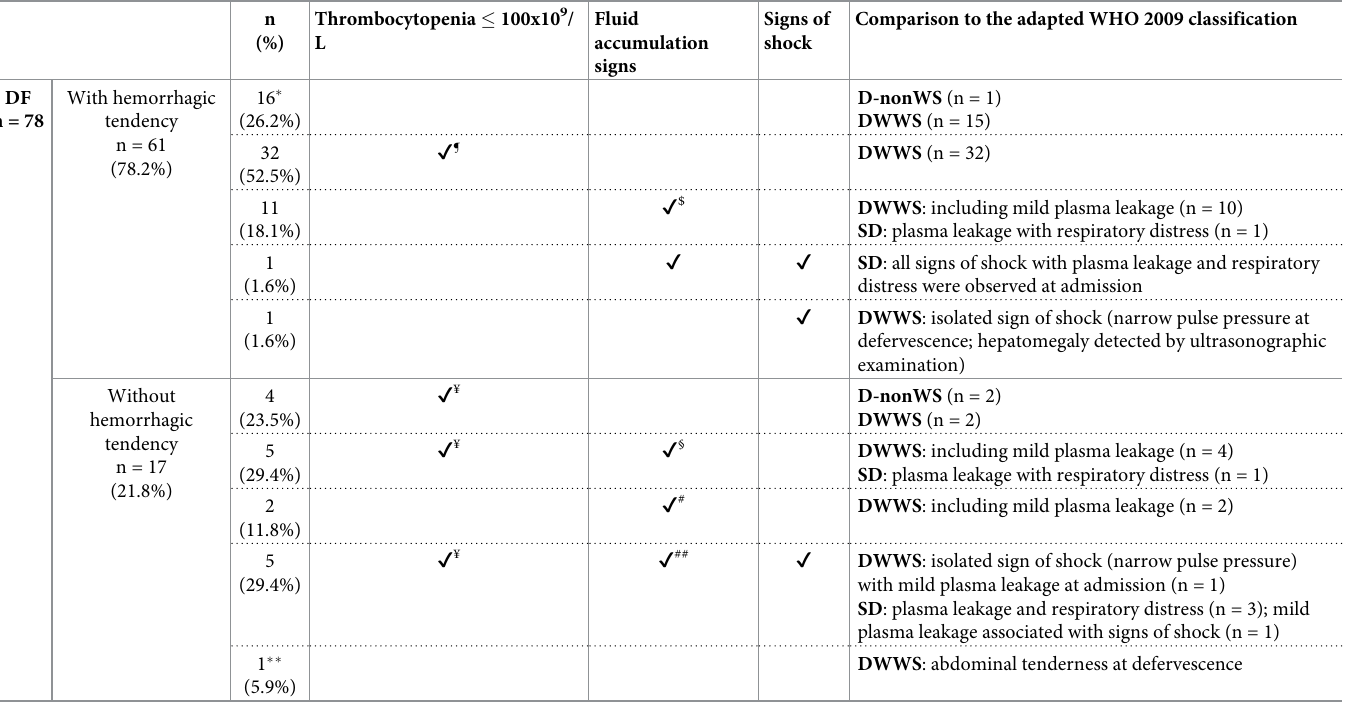
Fluid Signs of Comparison to the adapted WHO 2009 classification accumulation shock signs